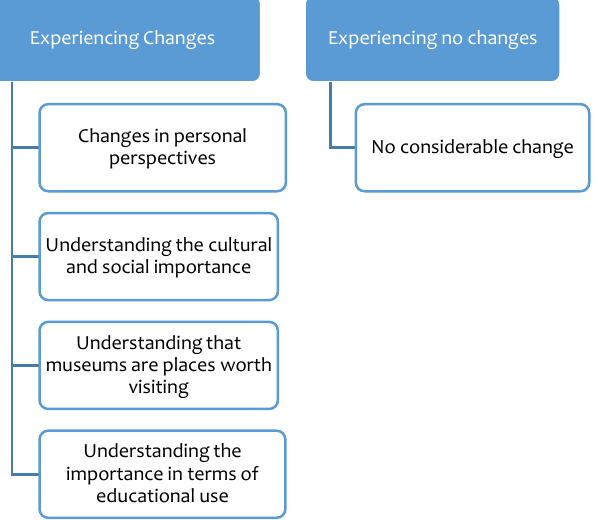
Figure 1. The Prospective Teachers’ Views on Museums after Taking the Museum Education